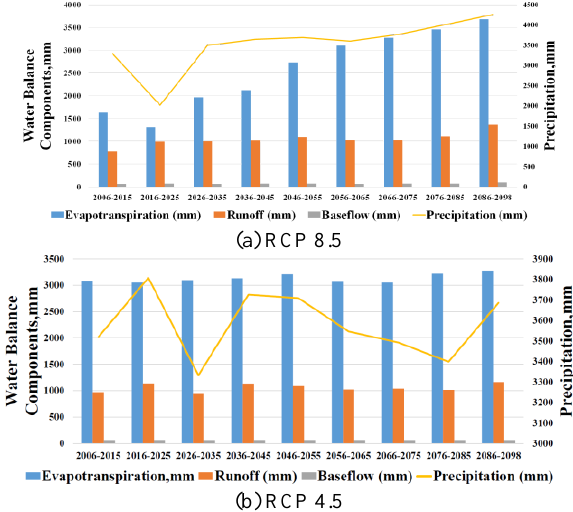
Figure 6. The decadal precipitation trend data from GFDL- ESM2M - RCAv4 for Beas Basin In was observed that under both the scenario temperature (Figure 4) is showing ever increasing trend whereas precipitation (Figure 6) is showing increasing trend under RCP 8.5 and decreasing trend under RCP 4.5. Definitely these changes in climatic parameters will affect hydrology of the basin. The change in water balance components under each scenario are shown in Figure 7. All the components; ET, runoff, baseflow; are showing almost increasing trend.